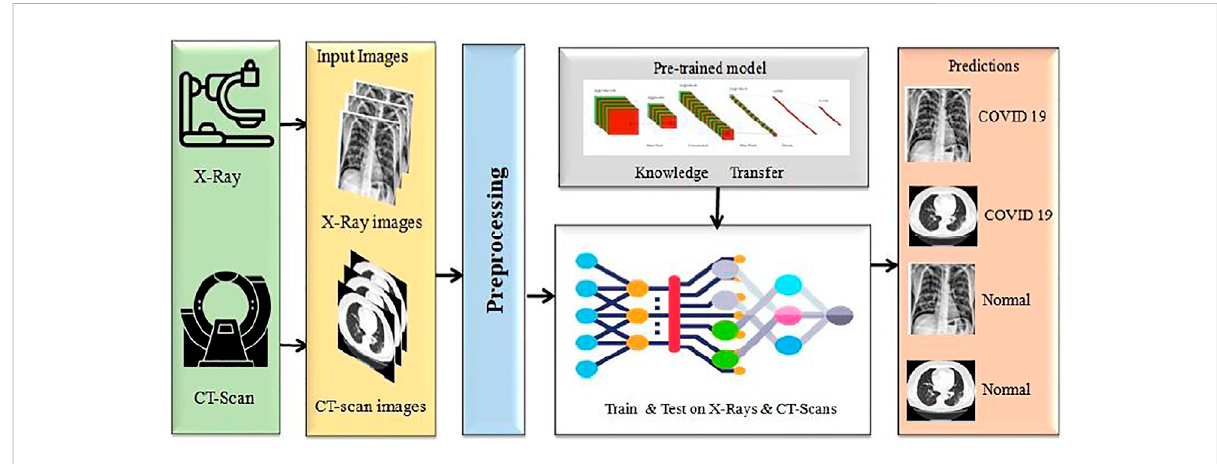
FIGURE 1 The proposed COVID-19 detection framework using both X-ray and CT-scan.